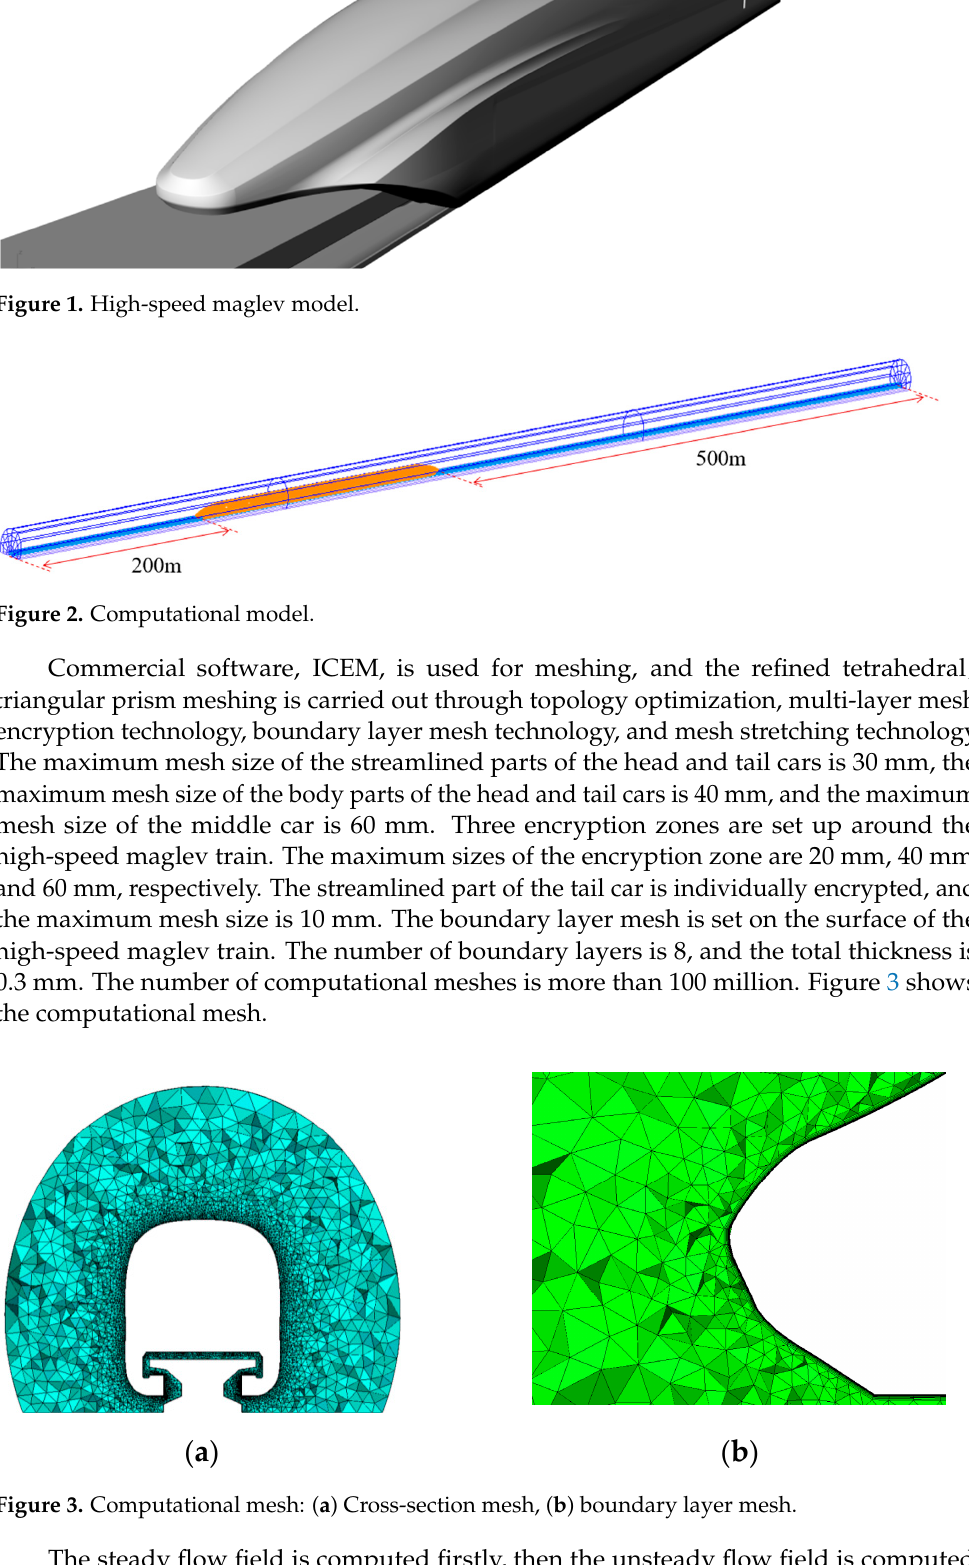
Figure 1. High-speed maglev model.